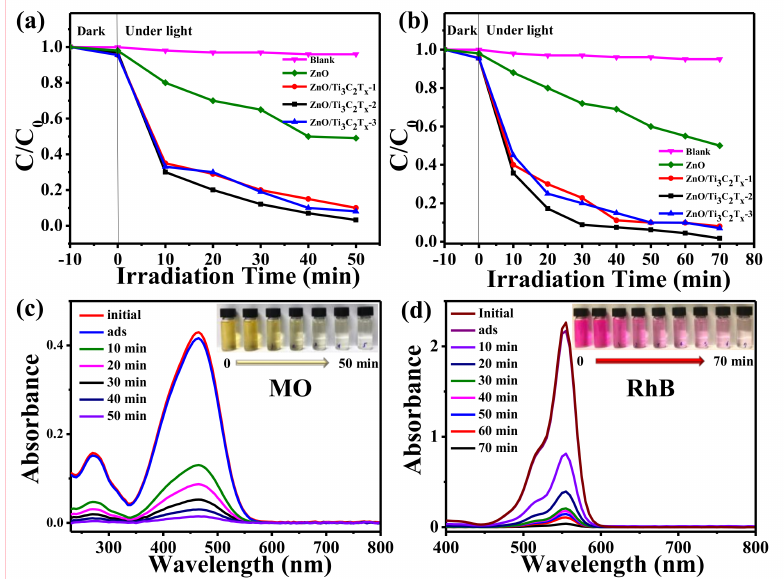
Figure 6. C / C 0 vs. irradiation time curves for the photocatalytic degradation of ( a ) MO and ( b ) RhB, using pure ZnO and ZnO / Ti 3 C 2 T x hybrid structures as photocatalysts. Blank represents the spontaneous decomposition of MO and RhB without photocatalyst. The time-dependent UV-Vis absorption spectra of ( c ) MO and ( d ) RhB obtained from the ZnO / Ti 3 C 2 T x -2 hybrid structure are